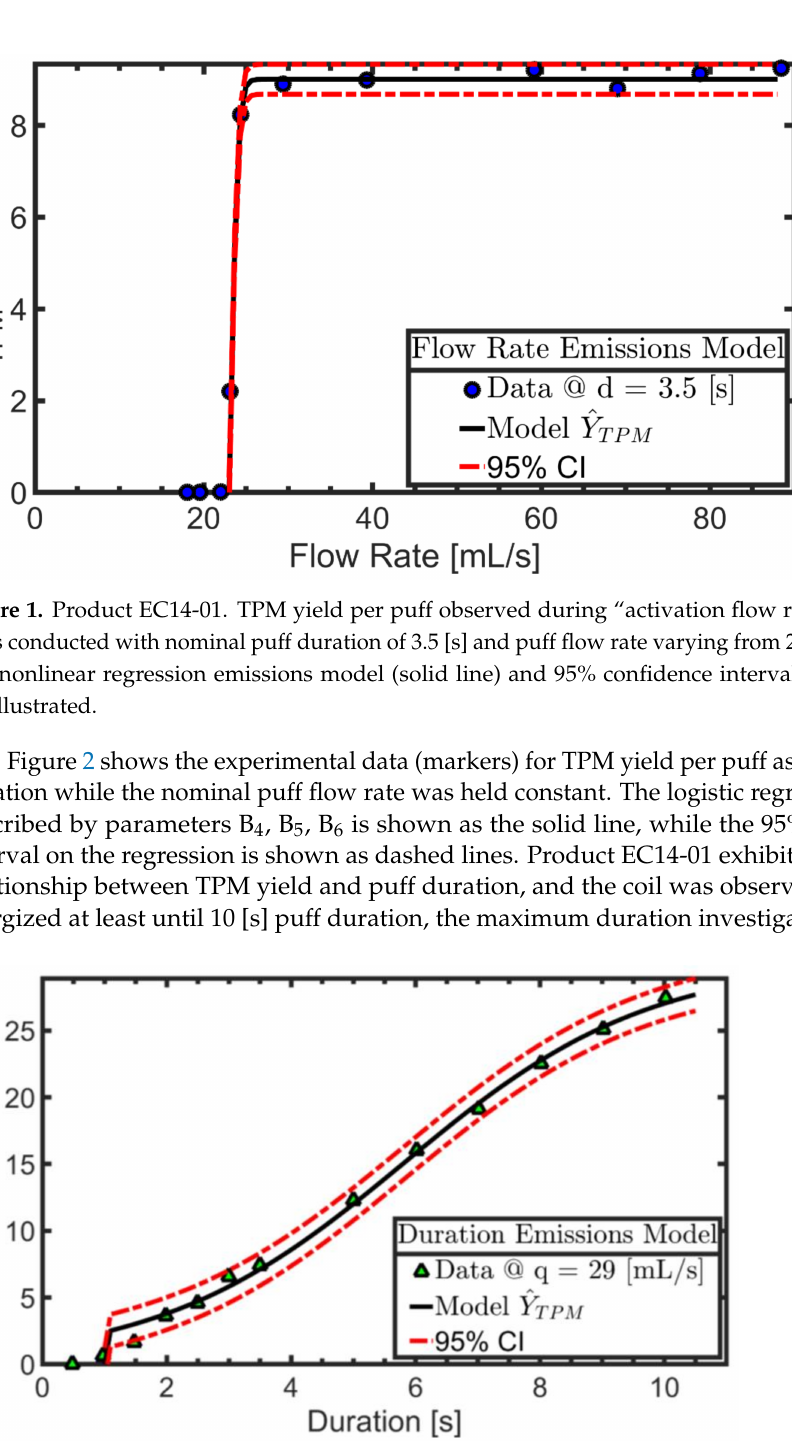
Figure 2. Product EC14-01. TPM yield per puff observed (markers) during “activation duration” screening trials conducted with nominal puff flow rate of 29 [mL/s] and puff duration varying from 1.0 to 10 [s]. The nonlinear regression emissions model (solid line) and 95% confidence interval (dashed line) are